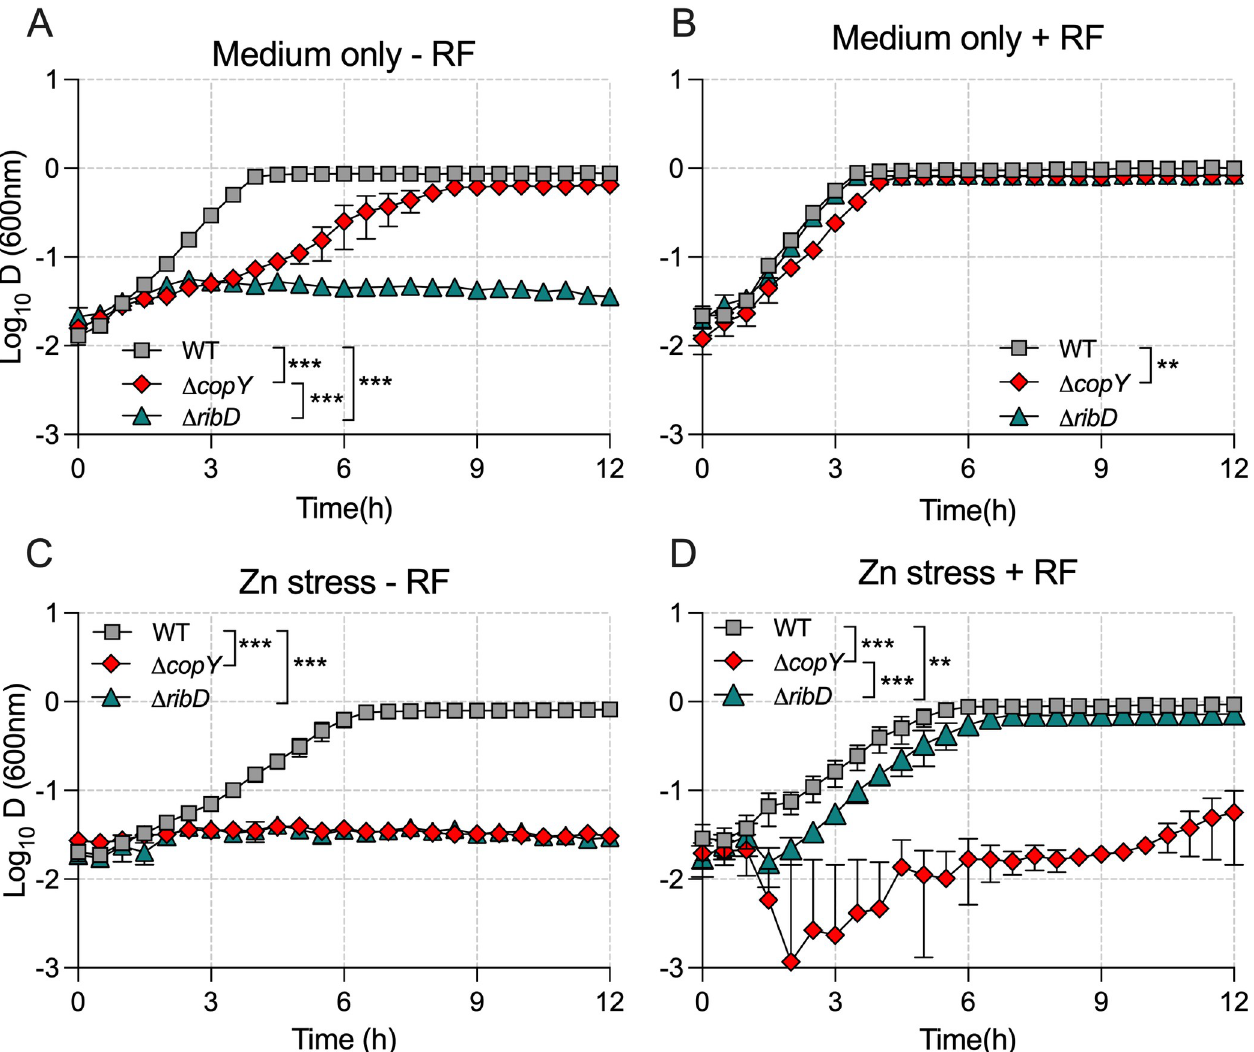
Fig 7. The effect of riboflavin on Zn stress resistance in GBS. WT, Δ copY and Δ ribD mutants were grown in MDM without supplemental RF (A), MDM supplemented with 0.5 mg/L RF (B), MDM supplemented with 0.1 mM Zn but without supplemental RF (C), or MDM supplemented with 0.1 mM Zn and 0.5 mg/L RF (D). Strains were compared by Area under the Curve analysis followed by ordinary one-way ANOVA and Holm Sidak multiple comparisons with significance between strains indicated via the legends in each panel ( � P < 0.05, �� P < 0.01, ��� P < 0.05). Data are mean ± S.E.M ( n = 3 biological repeats) measures of attenuance ( D at 600 nm